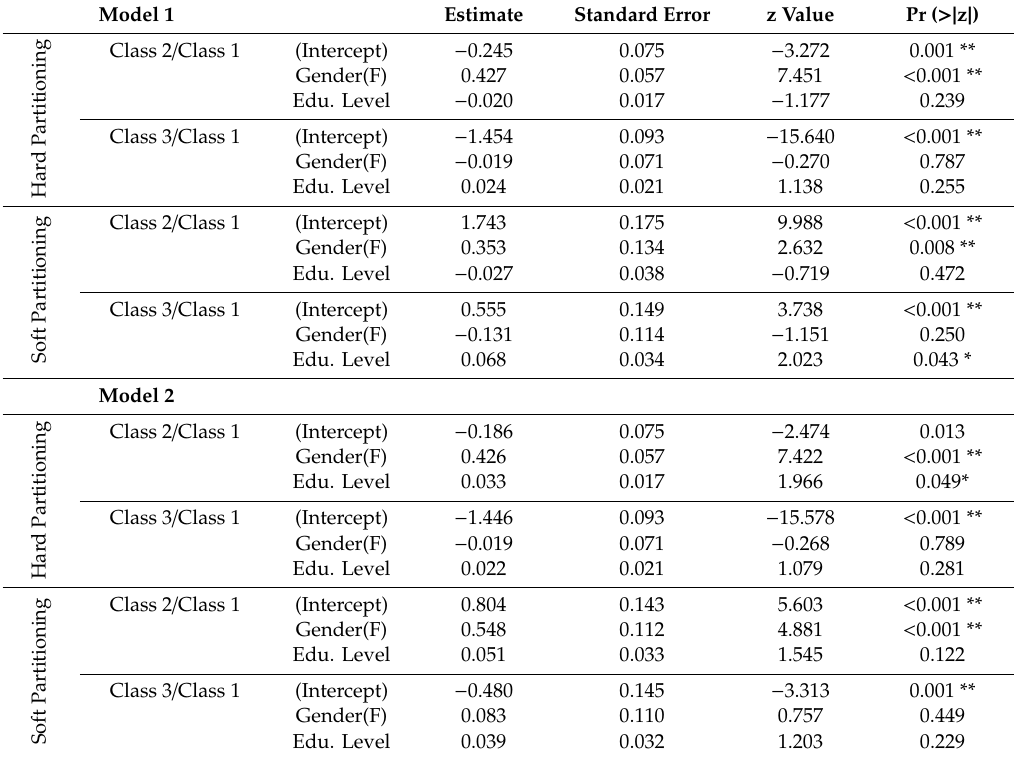
Table 3. Binomial Logistic Regression Coe ffi cients of gscaLCR with Add Health